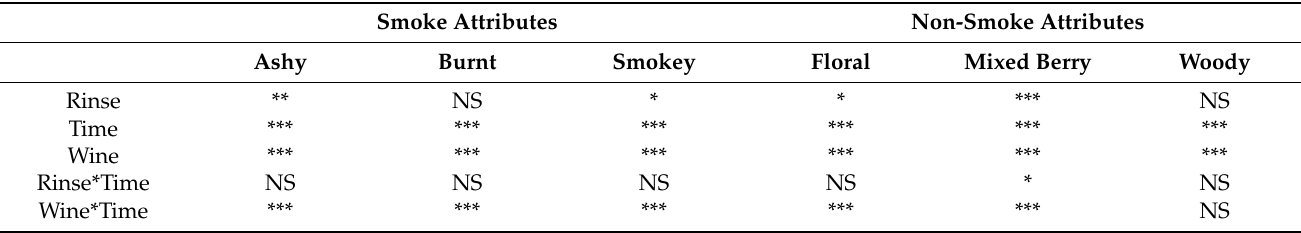
Table 3. Summary of the significance of random effects of all attributes according to three-way ANOVA from fixed-time- point intensity